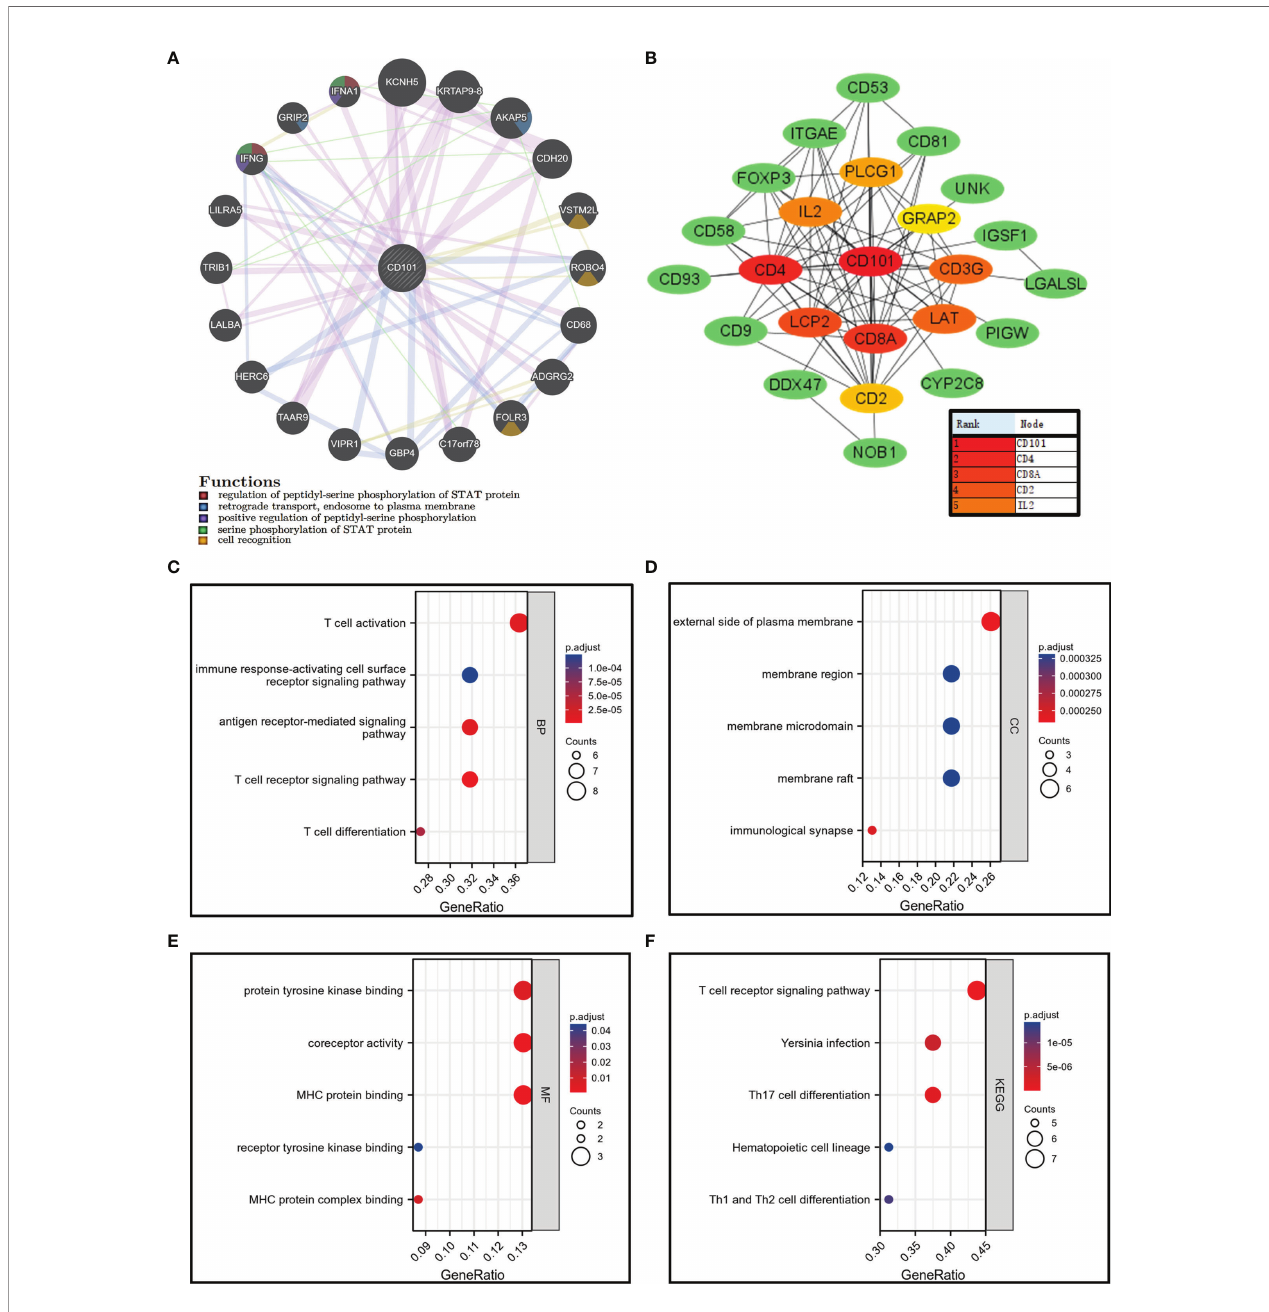
FIGURE 7 | Gene – gene interaction network, PPI network, and enrichment analysis related to binding proteins of CD101. (A) CD101 related gene – gene interaction network. (B) CD101-associated PPI network. (C – E) GO analysis. (F) KEGG